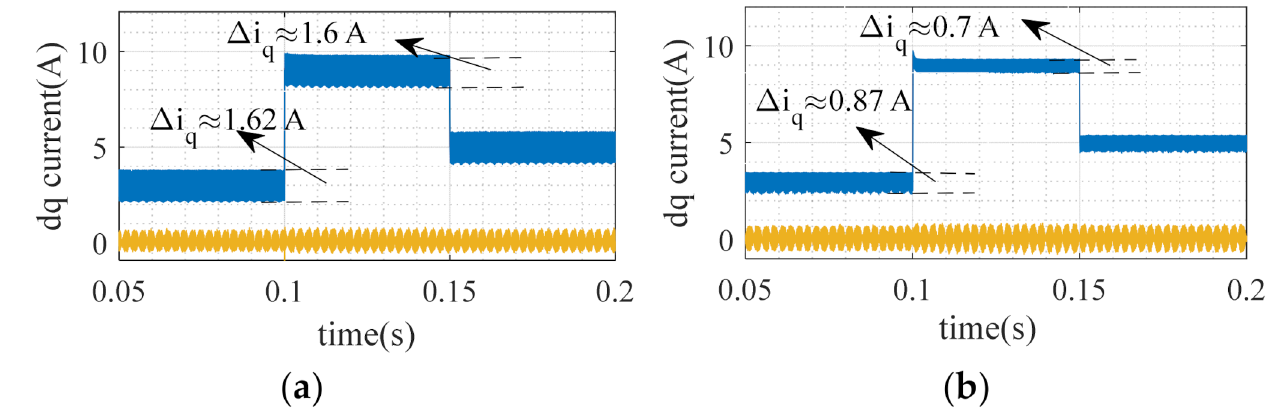
Figure 6. d - and q -axis current response: ( a ) SMC system with the FPRL; ( b ) SMC system with the